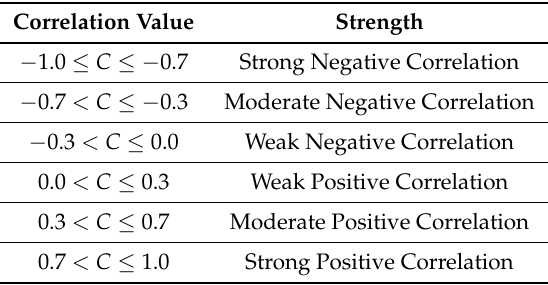
Table 3. The scale of correlation strength